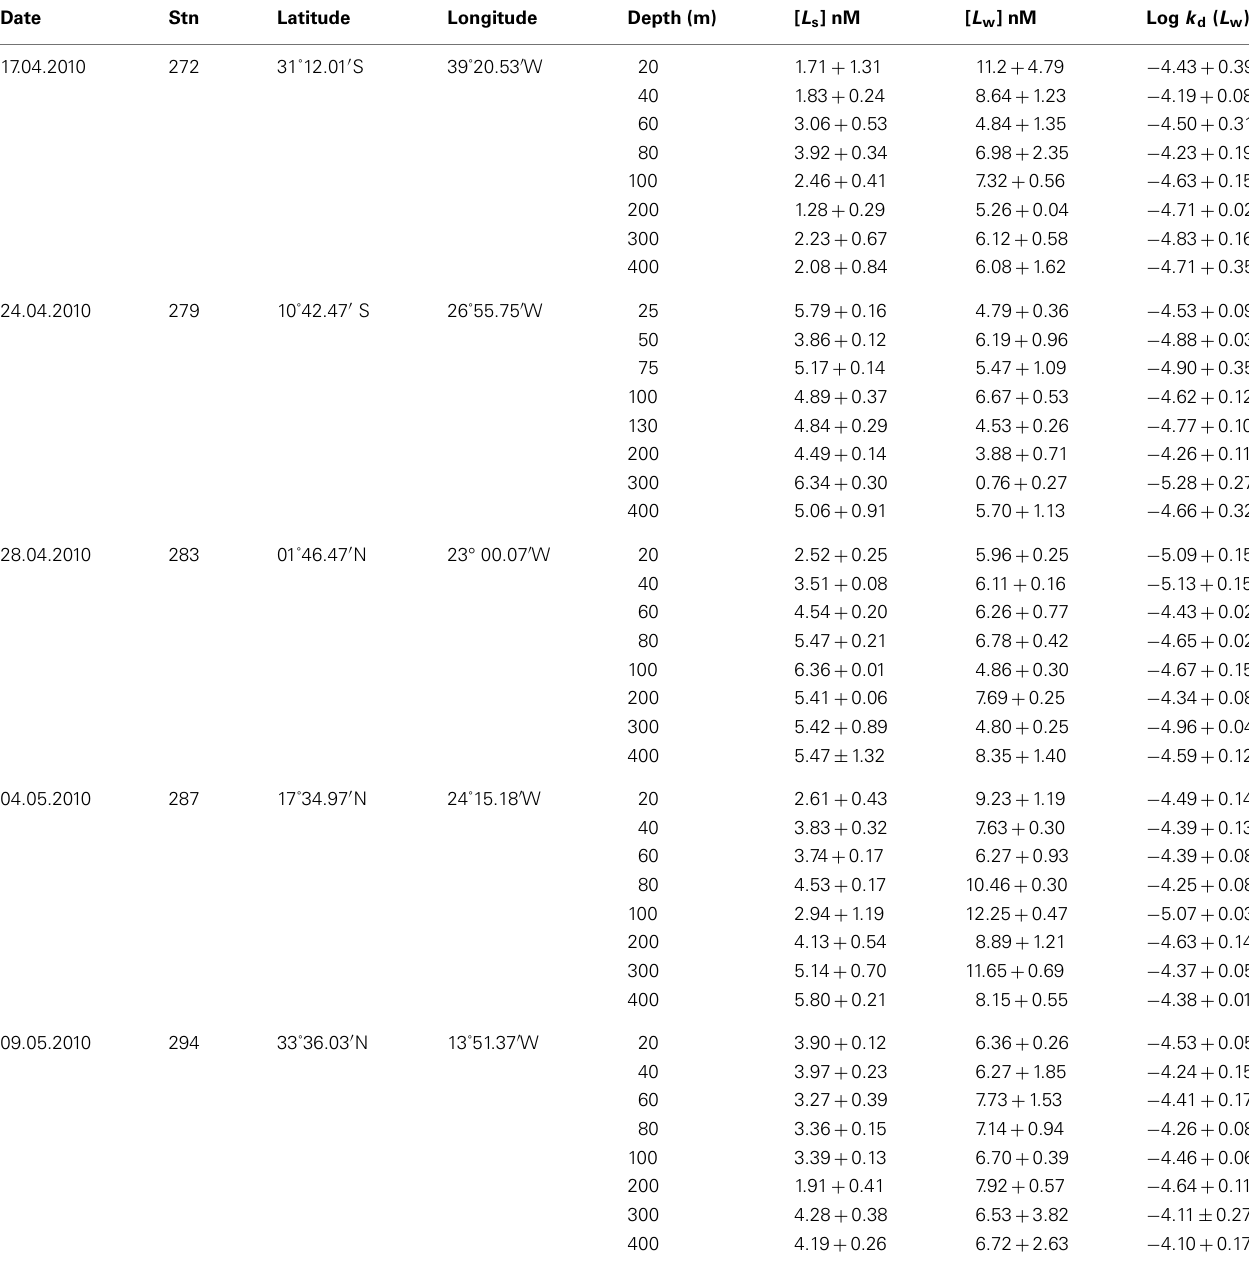
TableA1 | Fe sol -KIN: 55 Fe kinetic experiment – iron